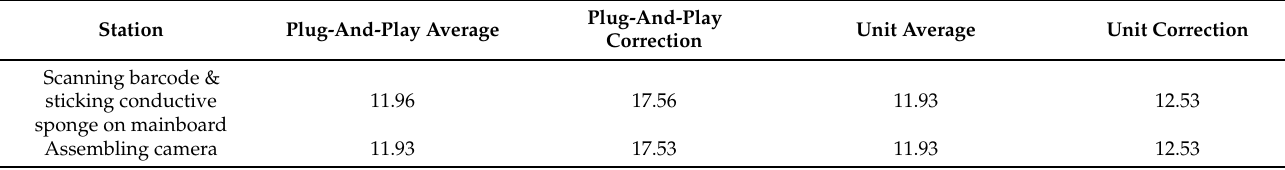
Table 5. Working Hours Design of Zero Automation